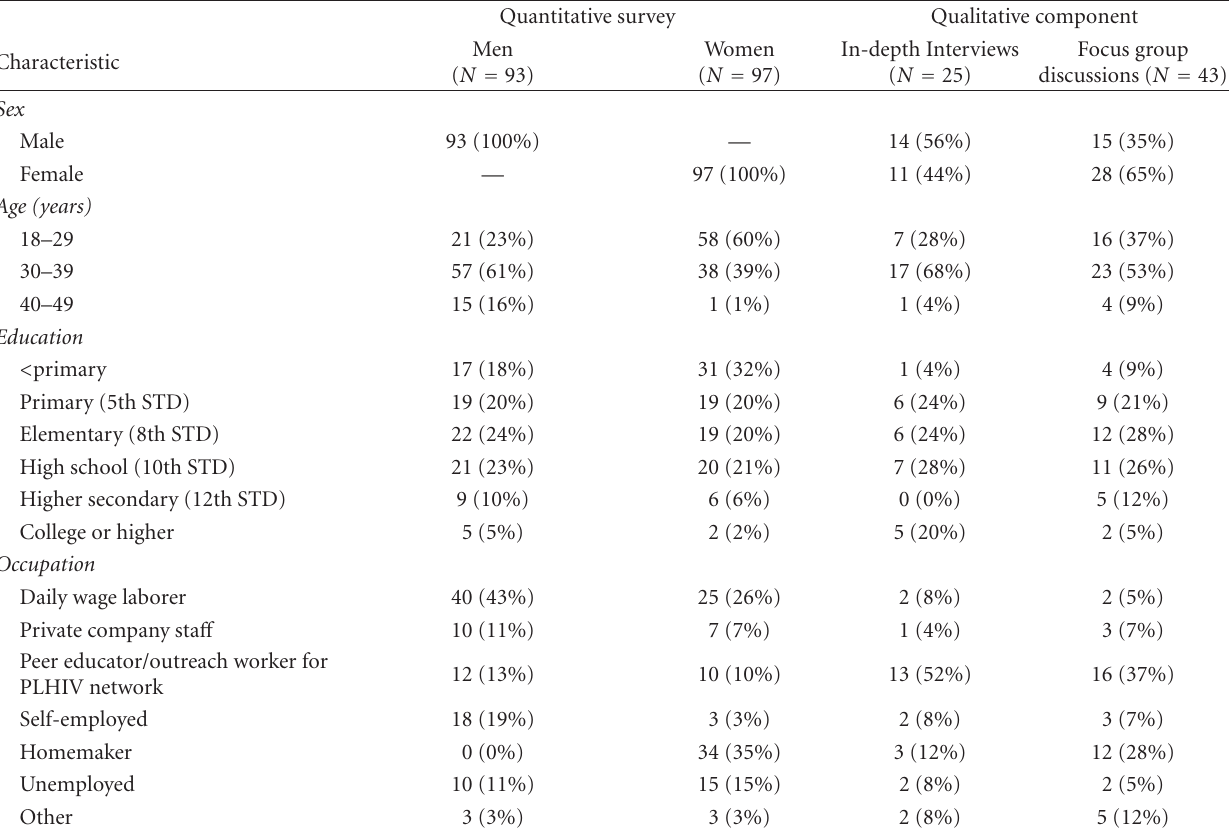
Table 1: Sociodemographic characteristics of study participants.